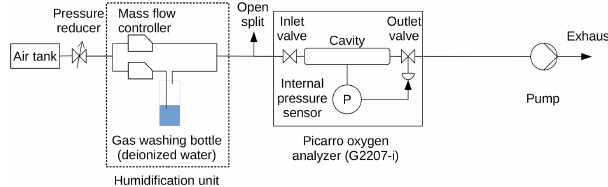
Figure 3. Experimental setup for spectroscopic cavity pressure